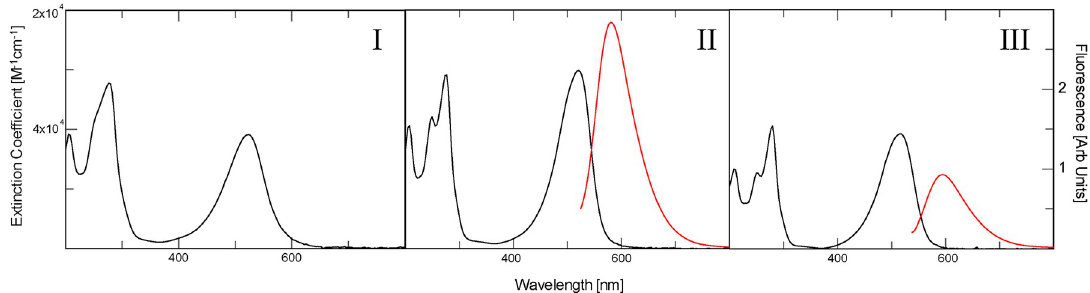
Fig 2. Absorption and fluorescence spectra of three safranine isomers. The absorption extinction coefficient is shown in black, while fluorescence is shown in red. I) The absorbance spectra of safranine I (this compound is not fluorescent). II) The absorption and fluorescence spectra of safranine II . III) The absorption and fluorescence spectra of safranine III . Fluorescence spectra were obtained by exciting the Safranine at their absorption maxima around 520 nm. The absorption at the wavelength of excitation was set to 0.1 AU at the long wavelength absorption maximum for both emission